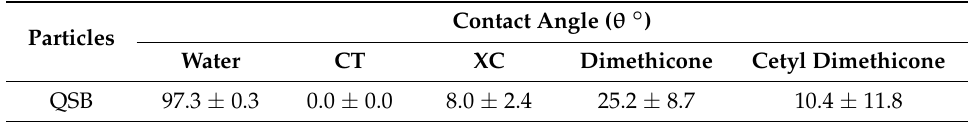
Table 3. Contact angle of water, Caprylic/Capric Triglyceride (CT), Phenoxyethyl Caprylate